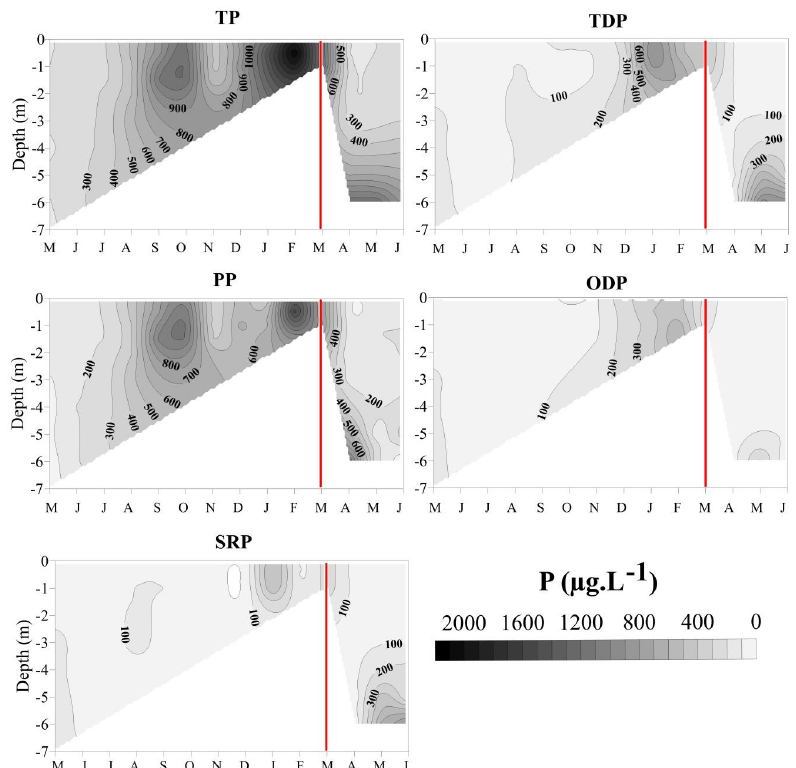
Figure 5. Total Phosphorus (TP), Total Dissolved Phosphorus (TDP), Particulate Phosphorus (PP), Dissolved Organic Phosphorus (ODP) and Soluble Reactive Phosphorus (SRP) in Gargalheiras reservoir from May 2015 to June 2016. The red line is indicating the highest rainfall in the period, which contributed to the increase in water depth, as can be seen in the